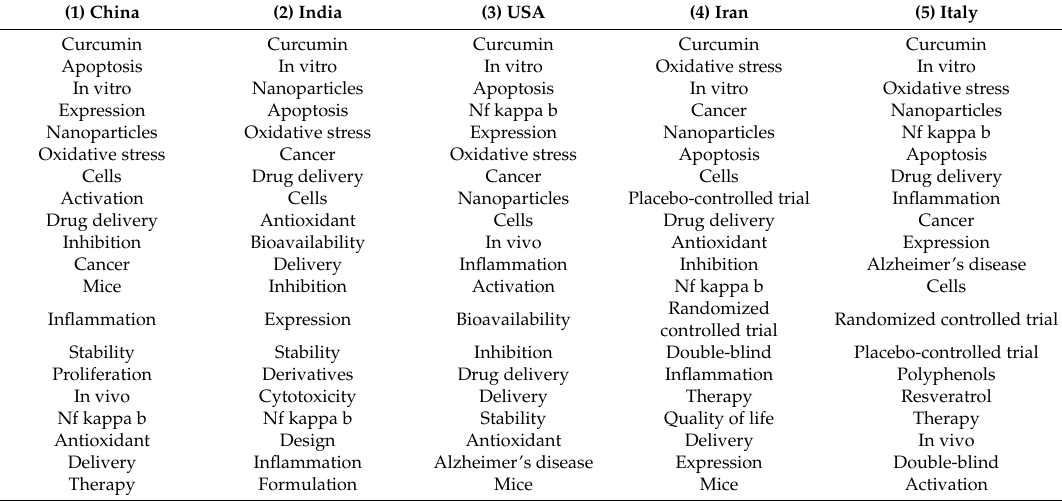
Table 5. The top 20 recurring keywords, in descending order, used in the publications contributed by the top five most productive countries since